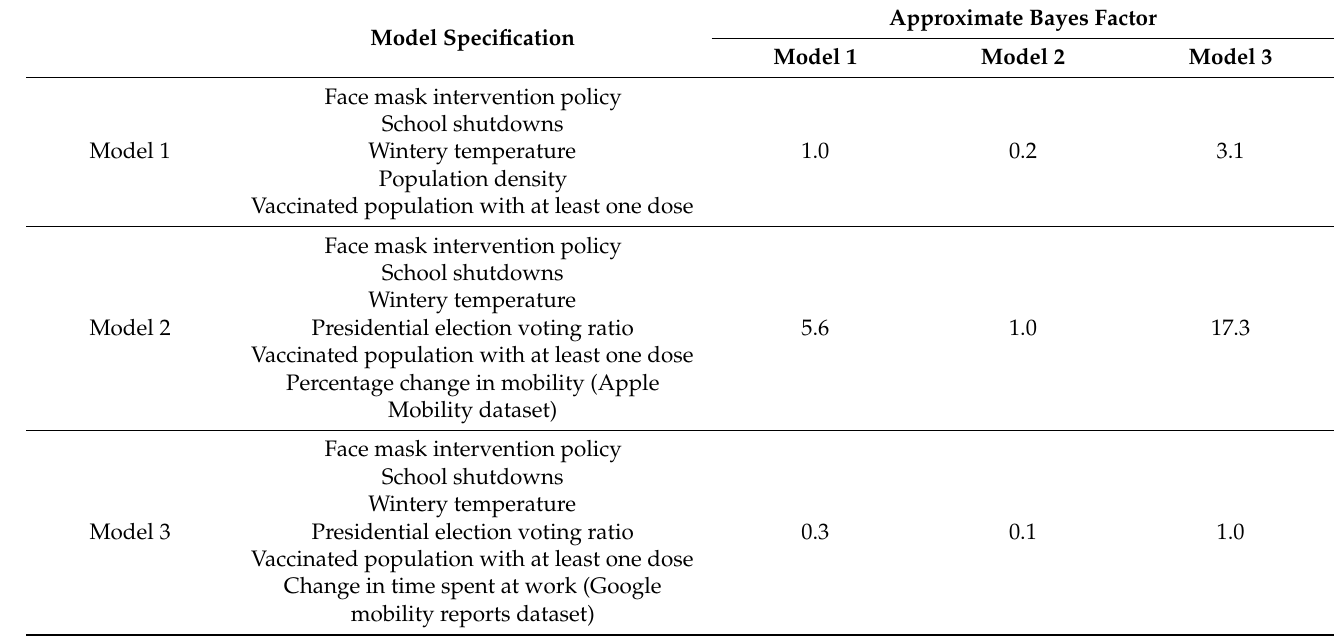
Table 2. Three retained spatial SEIR models: specification and approximate Bayes